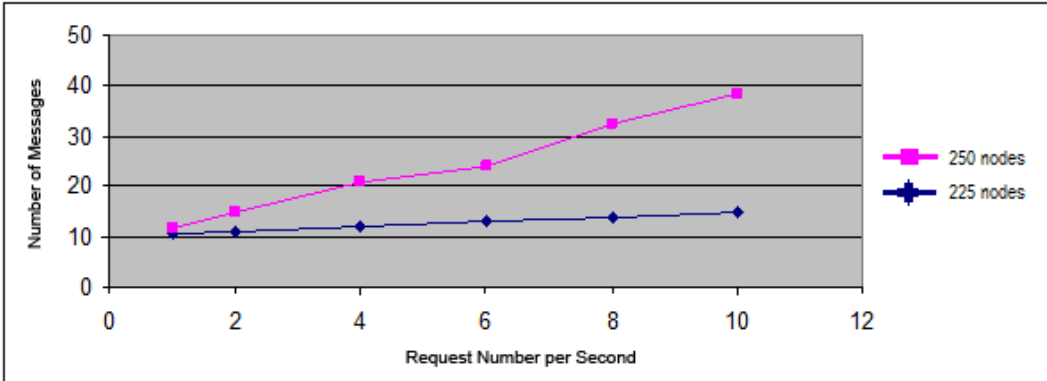
Figure 14. Control message number against to number of requests per